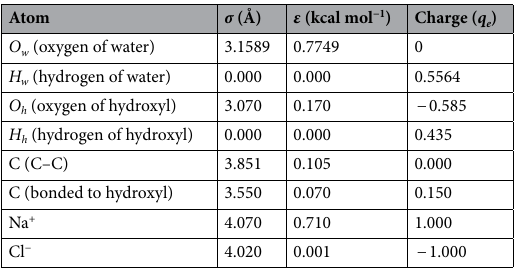
Table 1. LJ parameters charges of atoms in the